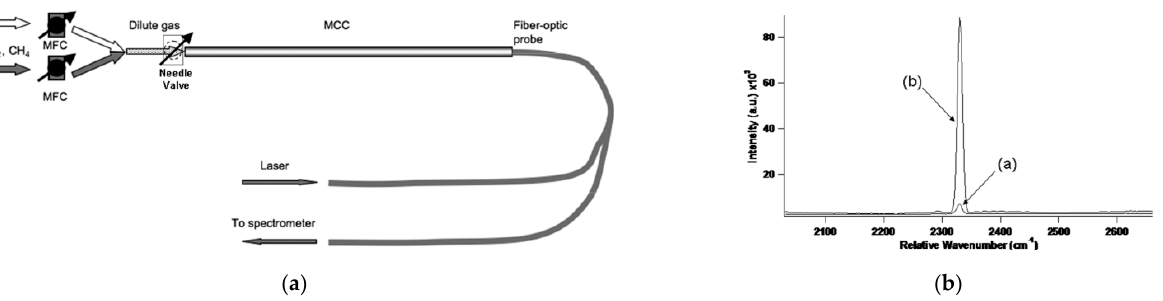
Figure 12. ( a ) Experimental setup for the collection of MCC Raman scatter. ( b ) Comparison of experimental results of H 2 in air and MCC. Reprinted with permission from [69] © The Optical Society.